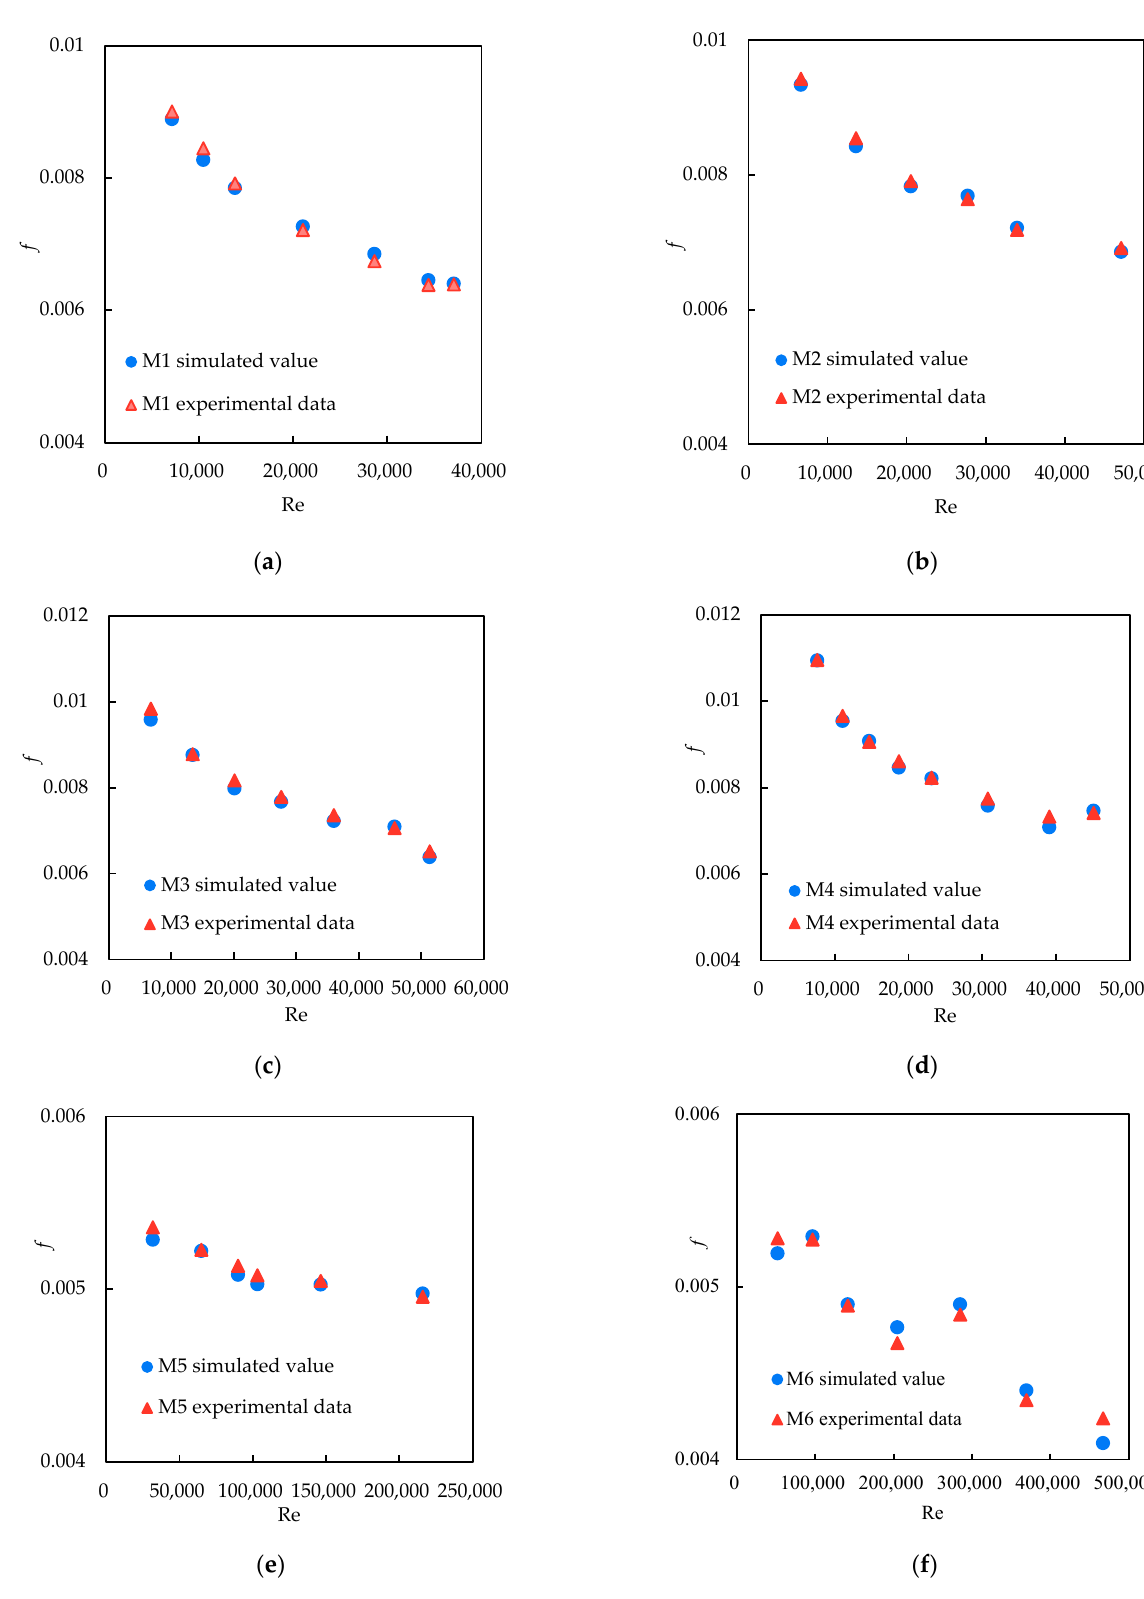
Figure 5. Comparison between simulated and experimental friction factor for M1-M6: ( a ) M1, ( b ) M2, ( c ) M3, ( d ) M4, ( e ) M5 and ( f ) M6. Table 2. Average error and standard deviation between simulation and experimental value for M1-M6 coiled tubing.